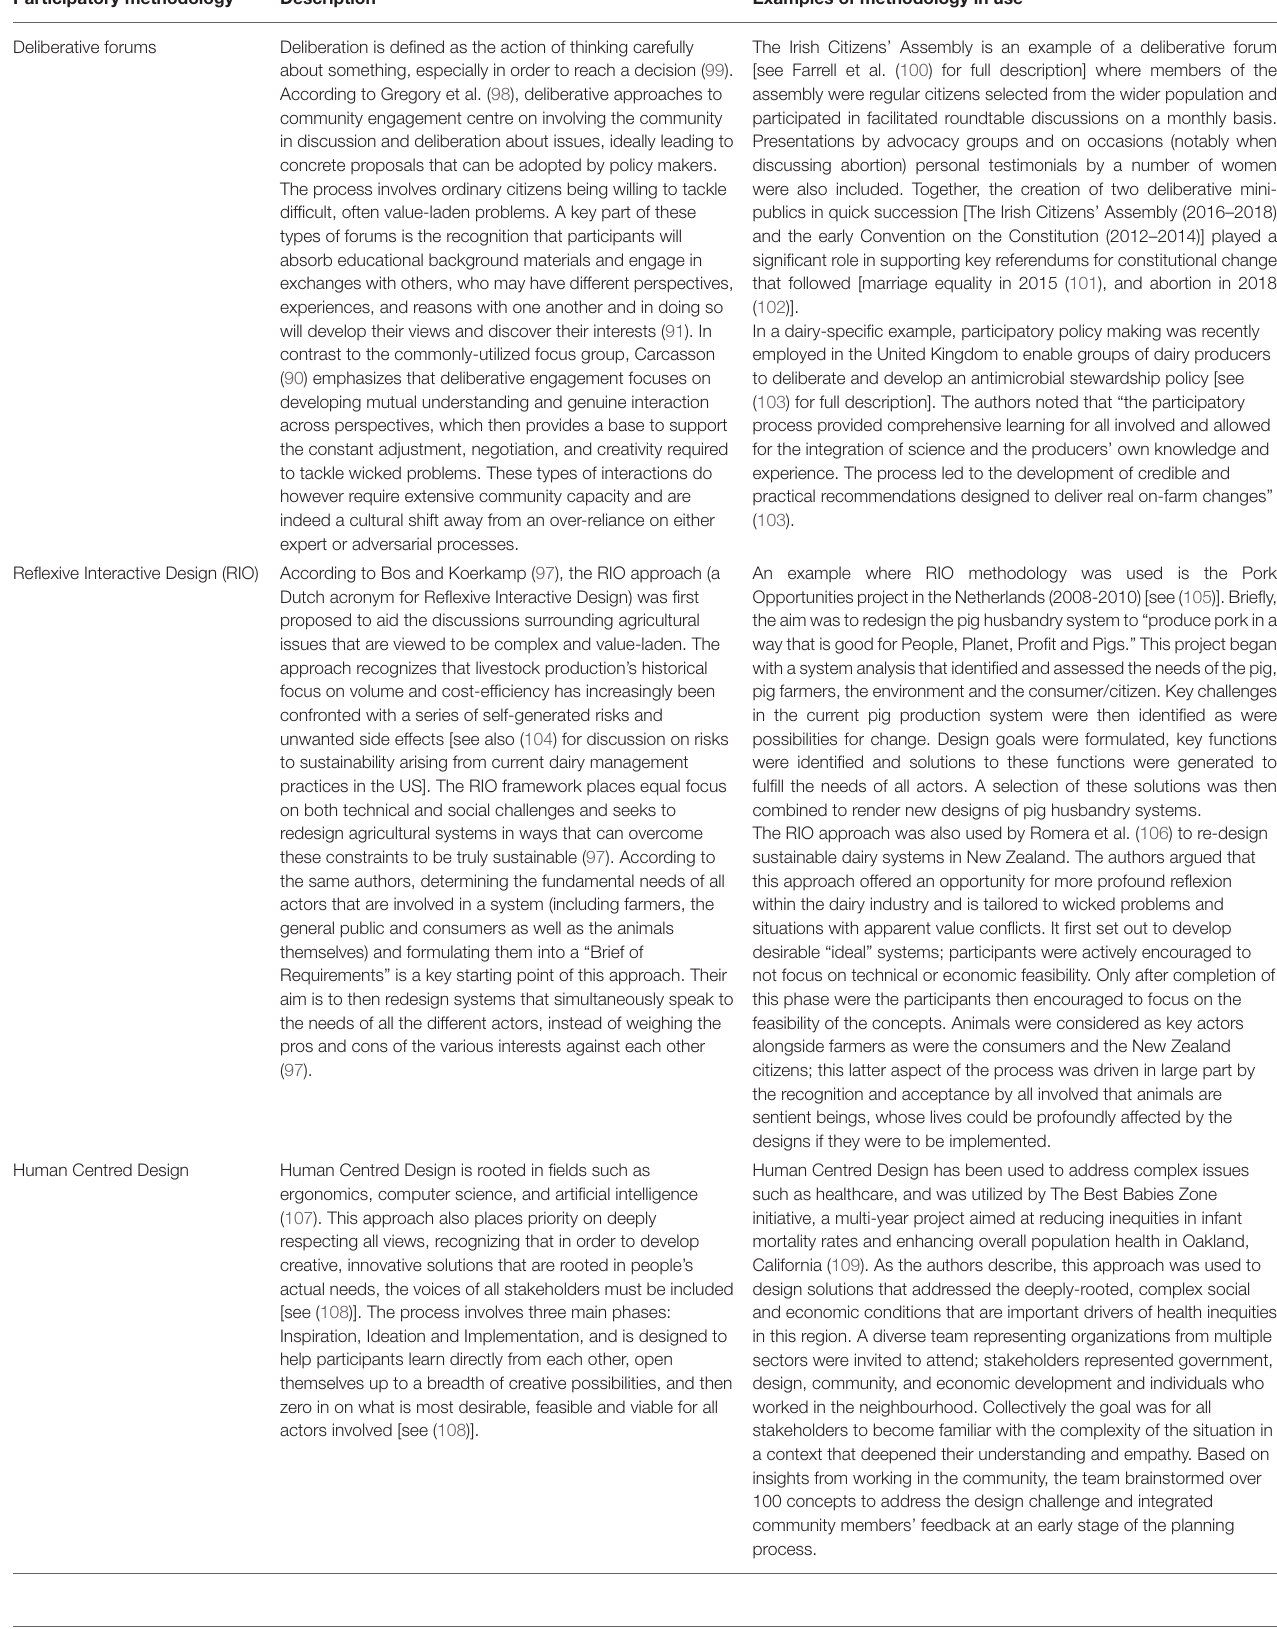
TABLE 2 | Brief descriptions of three participatory methodologies and examples where they have been used to tackle complex problems. Participatory